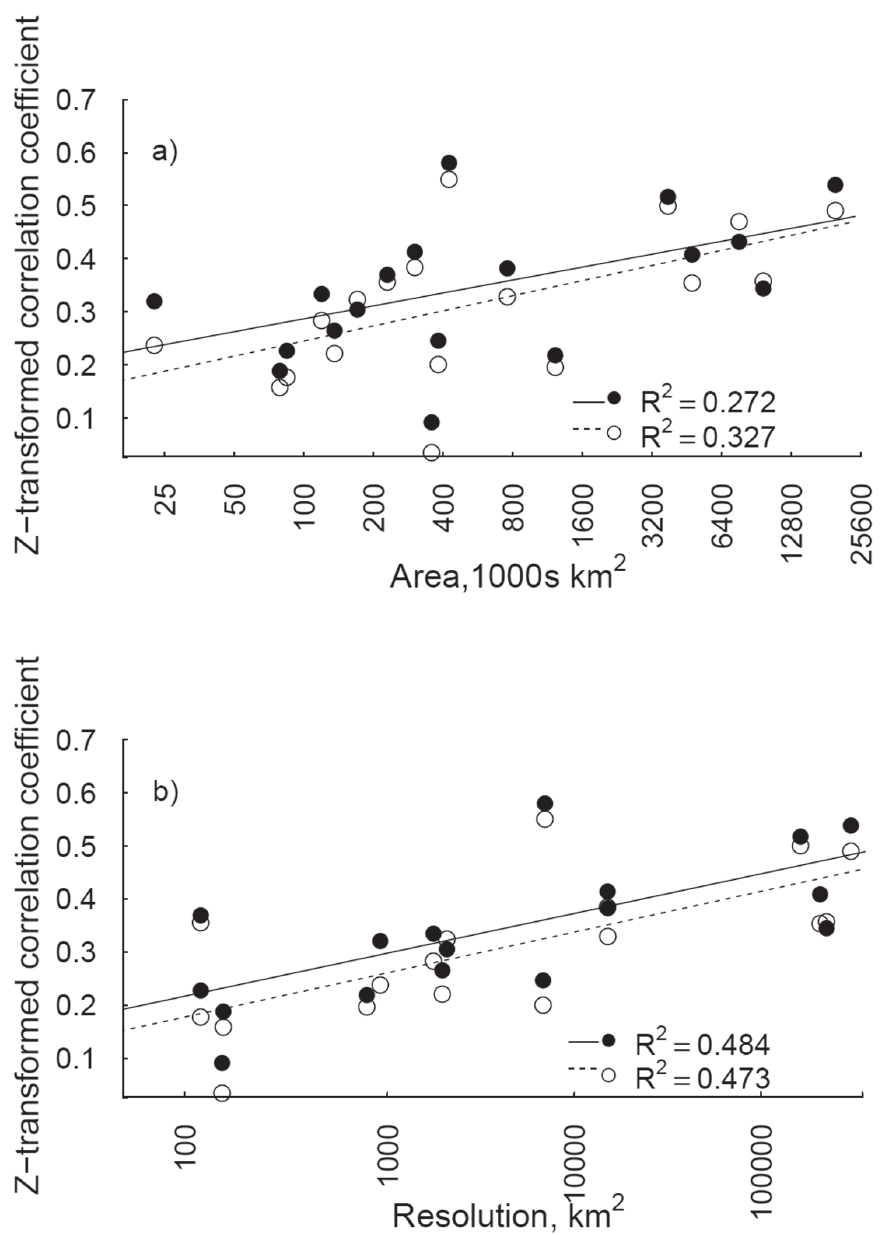
Figure 2. Relationships between the correlation strength (Z-transformed Spearman’s ρ coefficient) of GCW-derived invasiveness measures and regional distributions, and region area (a) and resolution (area of distribution units; b). Solid lines and circles represent the fitted models and correlation strengths per region, respectively, with number of references in the global compendium of weeds as the GCW-invasive- ness measure. Dashed lines and open circles are fitted models and region correlation strengths, respective- ly, with the number of GCW areas as the invasiveness measure. Note the natural log scale on the x